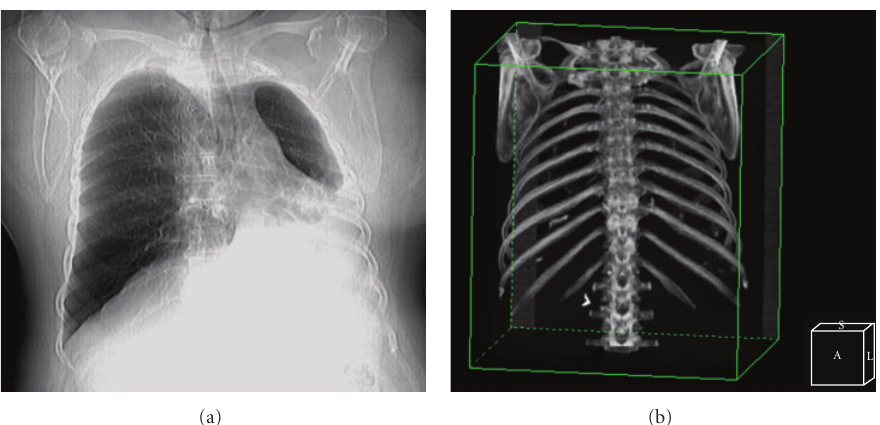
Figure 1: The radiological aspect could suggest a left basal pachypleuritis and a left lower lobe atelectasis, with ipsilateral mediastinal deviation and right lung herniation (a); 3D bone reconstruction revealed a symmetrical thoracic cage, discordant with an acquired retractile pleural-pulmonary pathology (b).